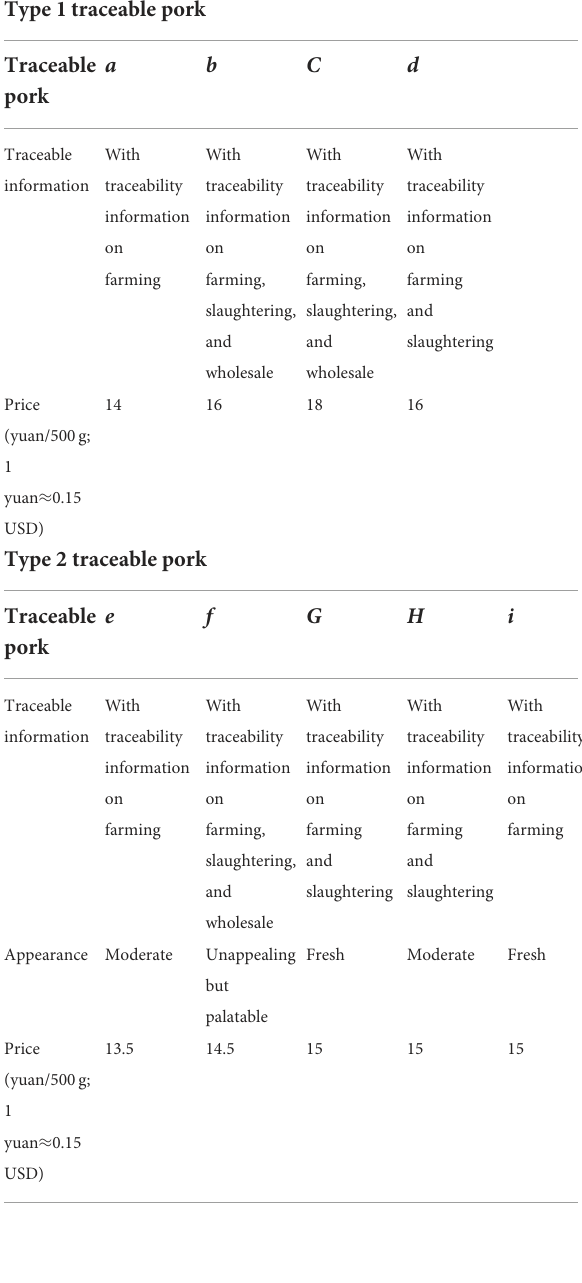
TABLE 1 Attributes and levels of